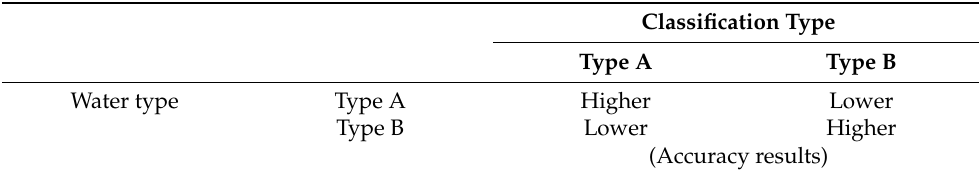
Table 2. Diagram of hypothesis prediction if H o is rejected and the Type A (higher water clarity) and Type B (lower water clarity) algorithms produce higher accuracies for their own water types.